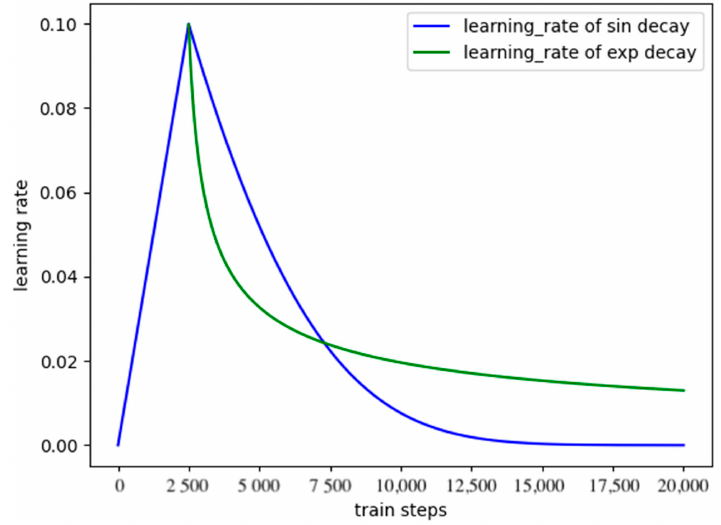
Figure 8. The learning rate of two warm-up